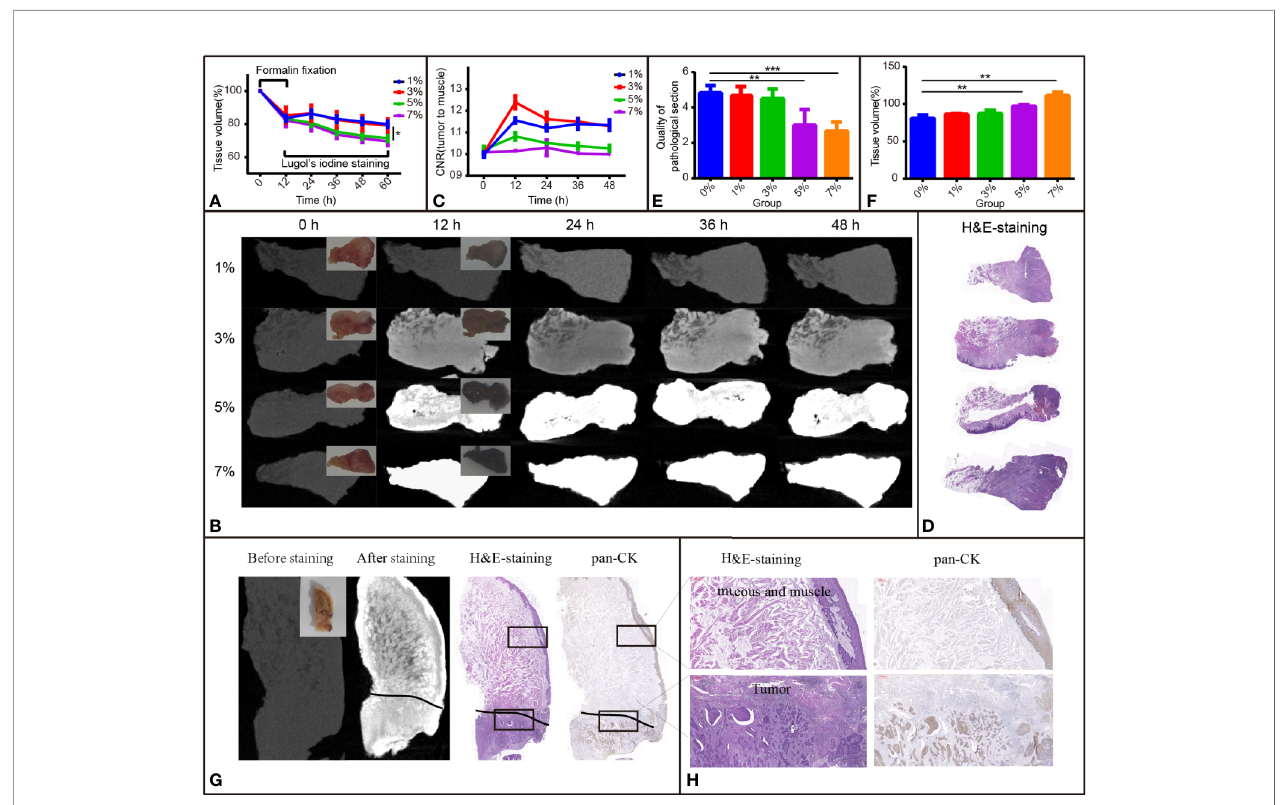
FIGURE 2 | I 2 -IK-enhanced micro-CT images for TSCC samples. (A) Tissue shrinkage during formalin fi xation and I 2 -IK staining time (tissue volume normalized to 100%). (B) Micro-CT image data at different times with different concentrations of I 2 -IK (insets indicate camera images of TSCC tumor tissue blocks). (C) CNR value of micro-CT images at different times with different concentrations of I 2 -IK. (D) H&E section of TSCC samples. (E, F) Tissue shrinkage and quality of pathological sections with different concentrations of I 2 -IK. (G) Micro-CT image before and after 3% I 2 -IK staining for 12 h and the H&E section, pan-CK section at the same level (black line indicates the tumor boundary). (H) Details of the H&E section and pan-CK section in the black boxes. (the above image shows mucous and muscle and the image below shows tumor tissues). ** P < 0.01, *** P <